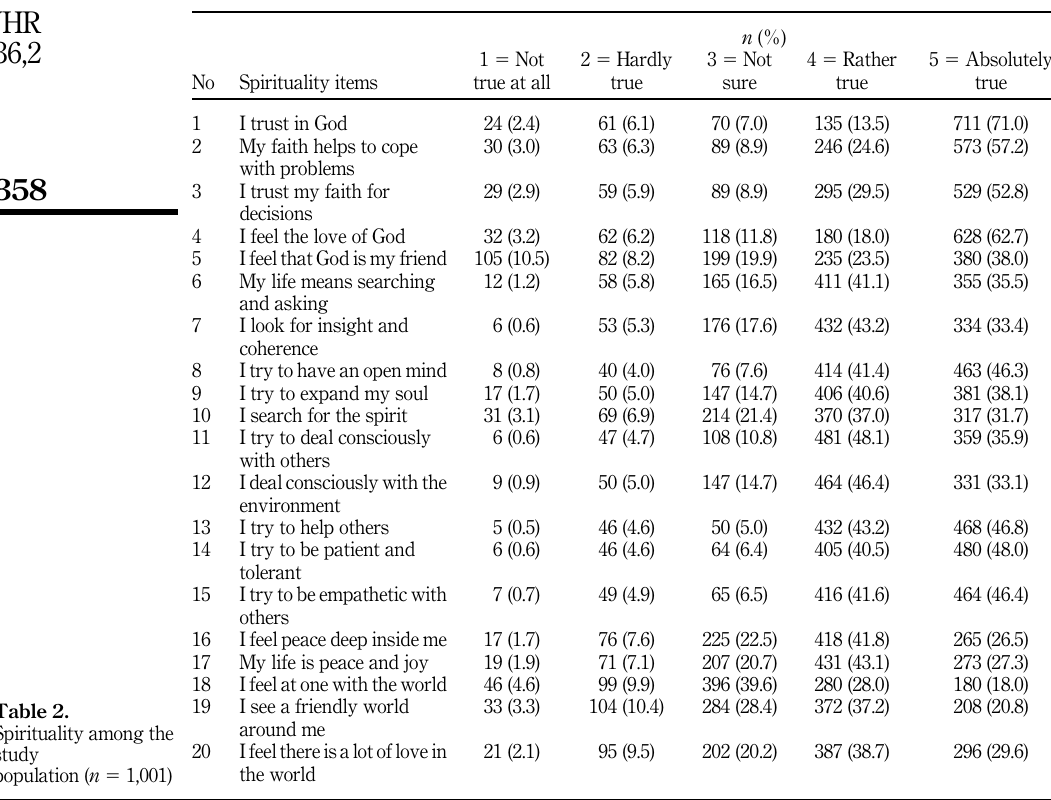
Table 2. Spirituality among